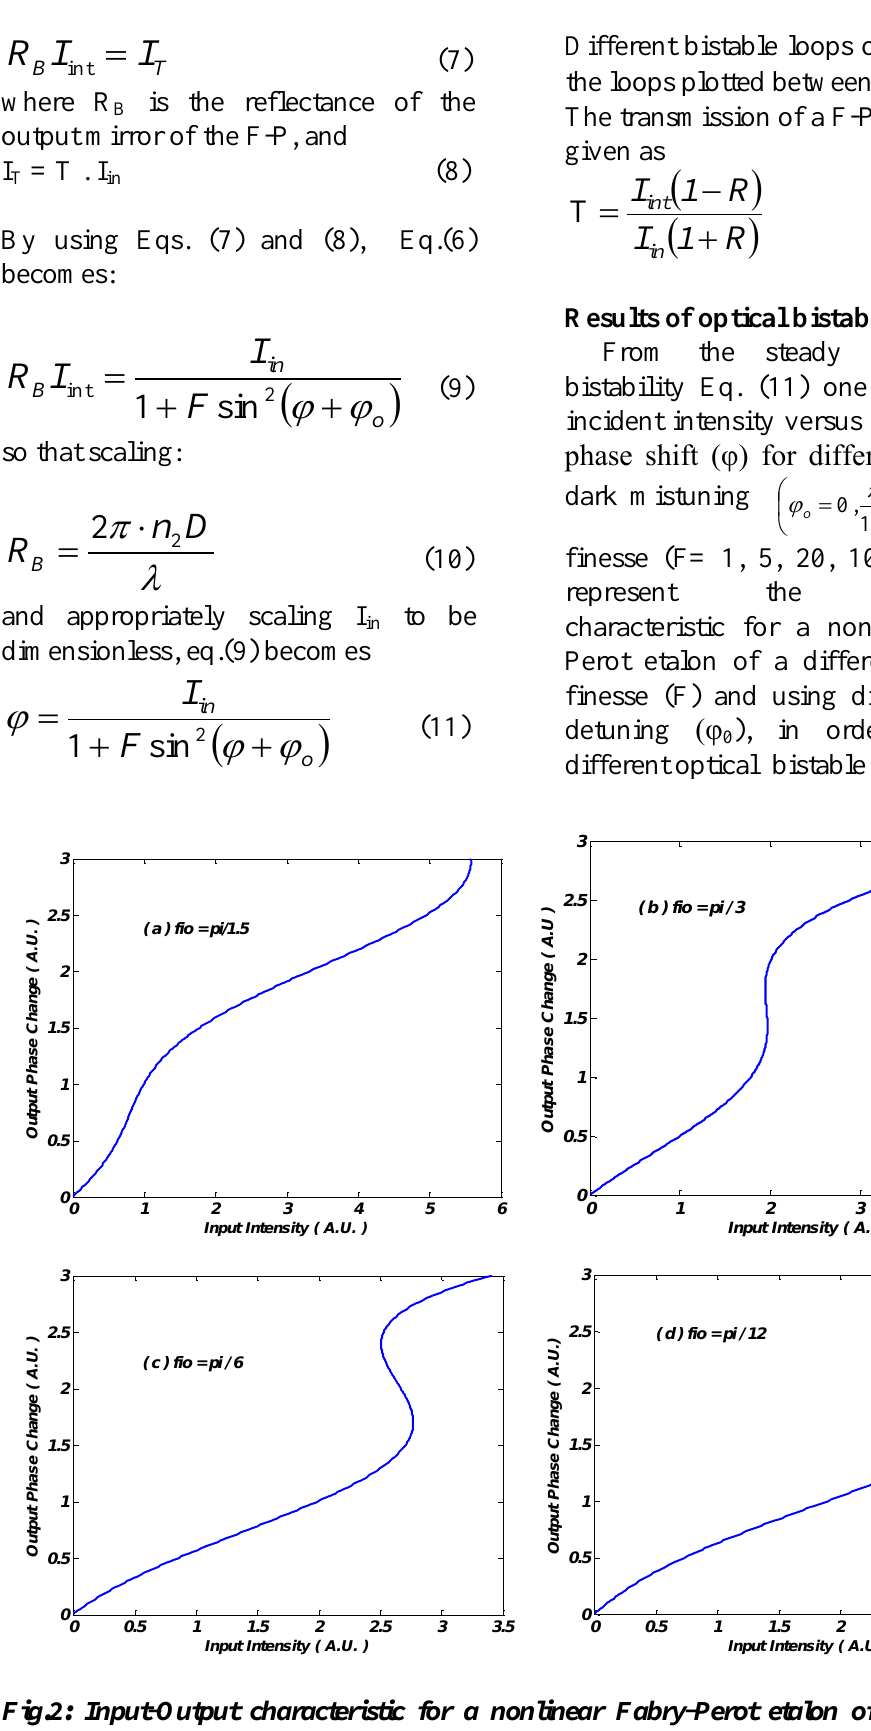
Fig.2: Input-Output characteristic for a nonlinear Fabry-Perot etalon of finesse value (F=1) and using different initial